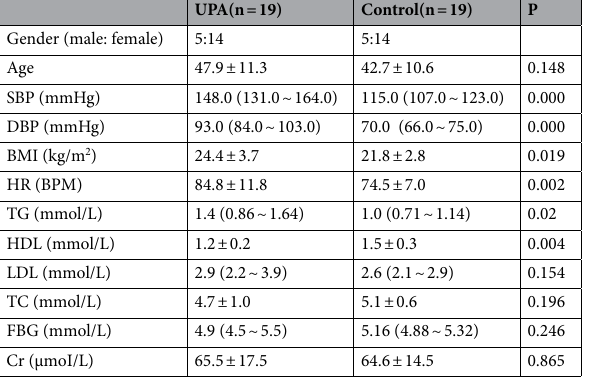
UPA(n = 19) Control(n = 19)